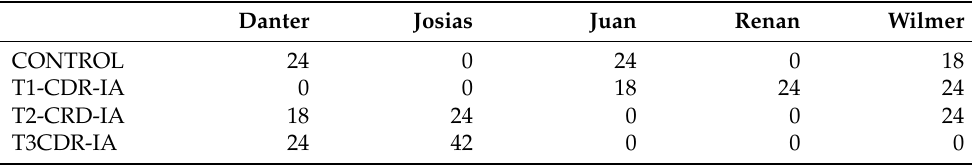
Table A4. Distribution of Observations by Collector and Treatment .